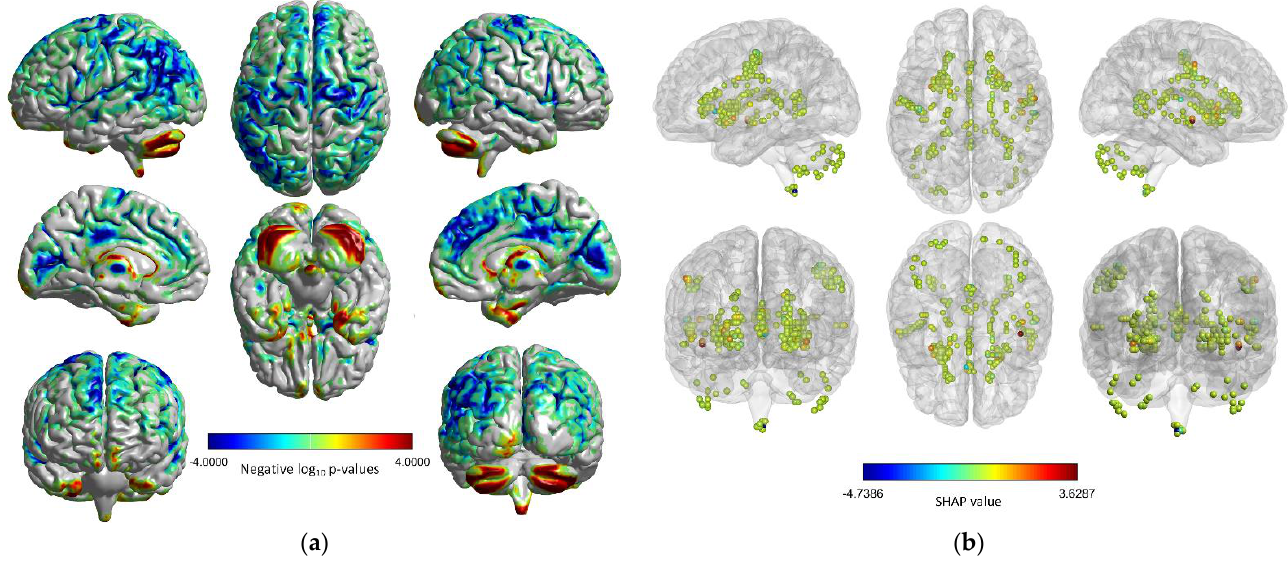
Figure 7. Volume − to − surface mapping and voxel SHAP values for the subject aged 63: ( a ) Brain mapping with mass univariate. Massively univariate group analysis with permuted OLS is performed to fit the test variables (age) independently to the target variable (brain imaging signals). Permutation tests are used to assess the significance of the relationship between the test variables and the target variables [41], and a max − type procedure is used to obtain family − corrected p − values; negative log 10 p − values are displayed as heat maps on the cortical surface, and ( b ) voxels with high SHAP values, which are identified by tiny nodes. The graphs were visualized with BrainNet Viewer [42].